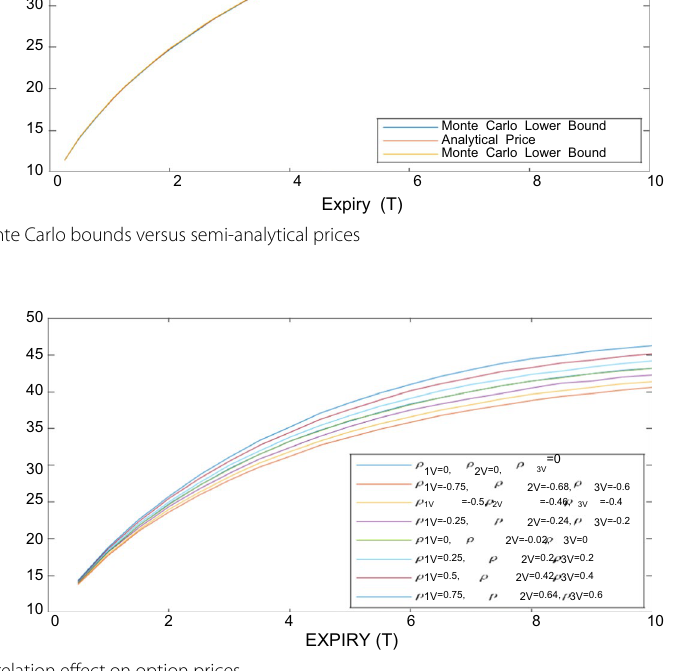
Fig. 6 Correlation effect on option